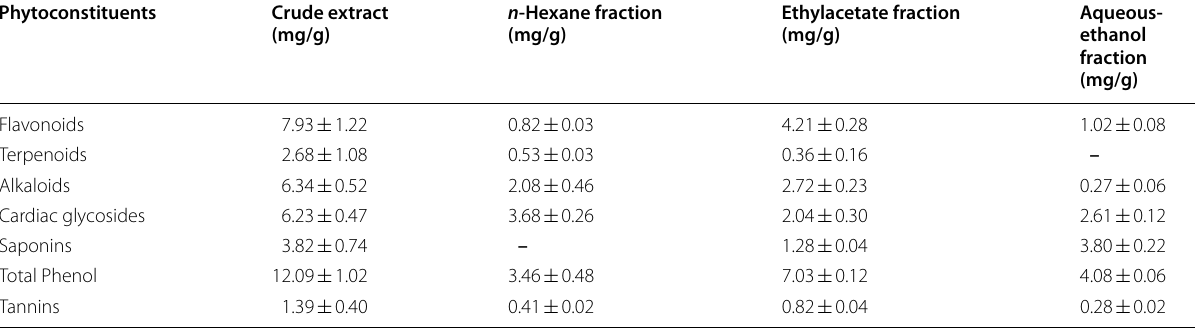
Values are presented as mean